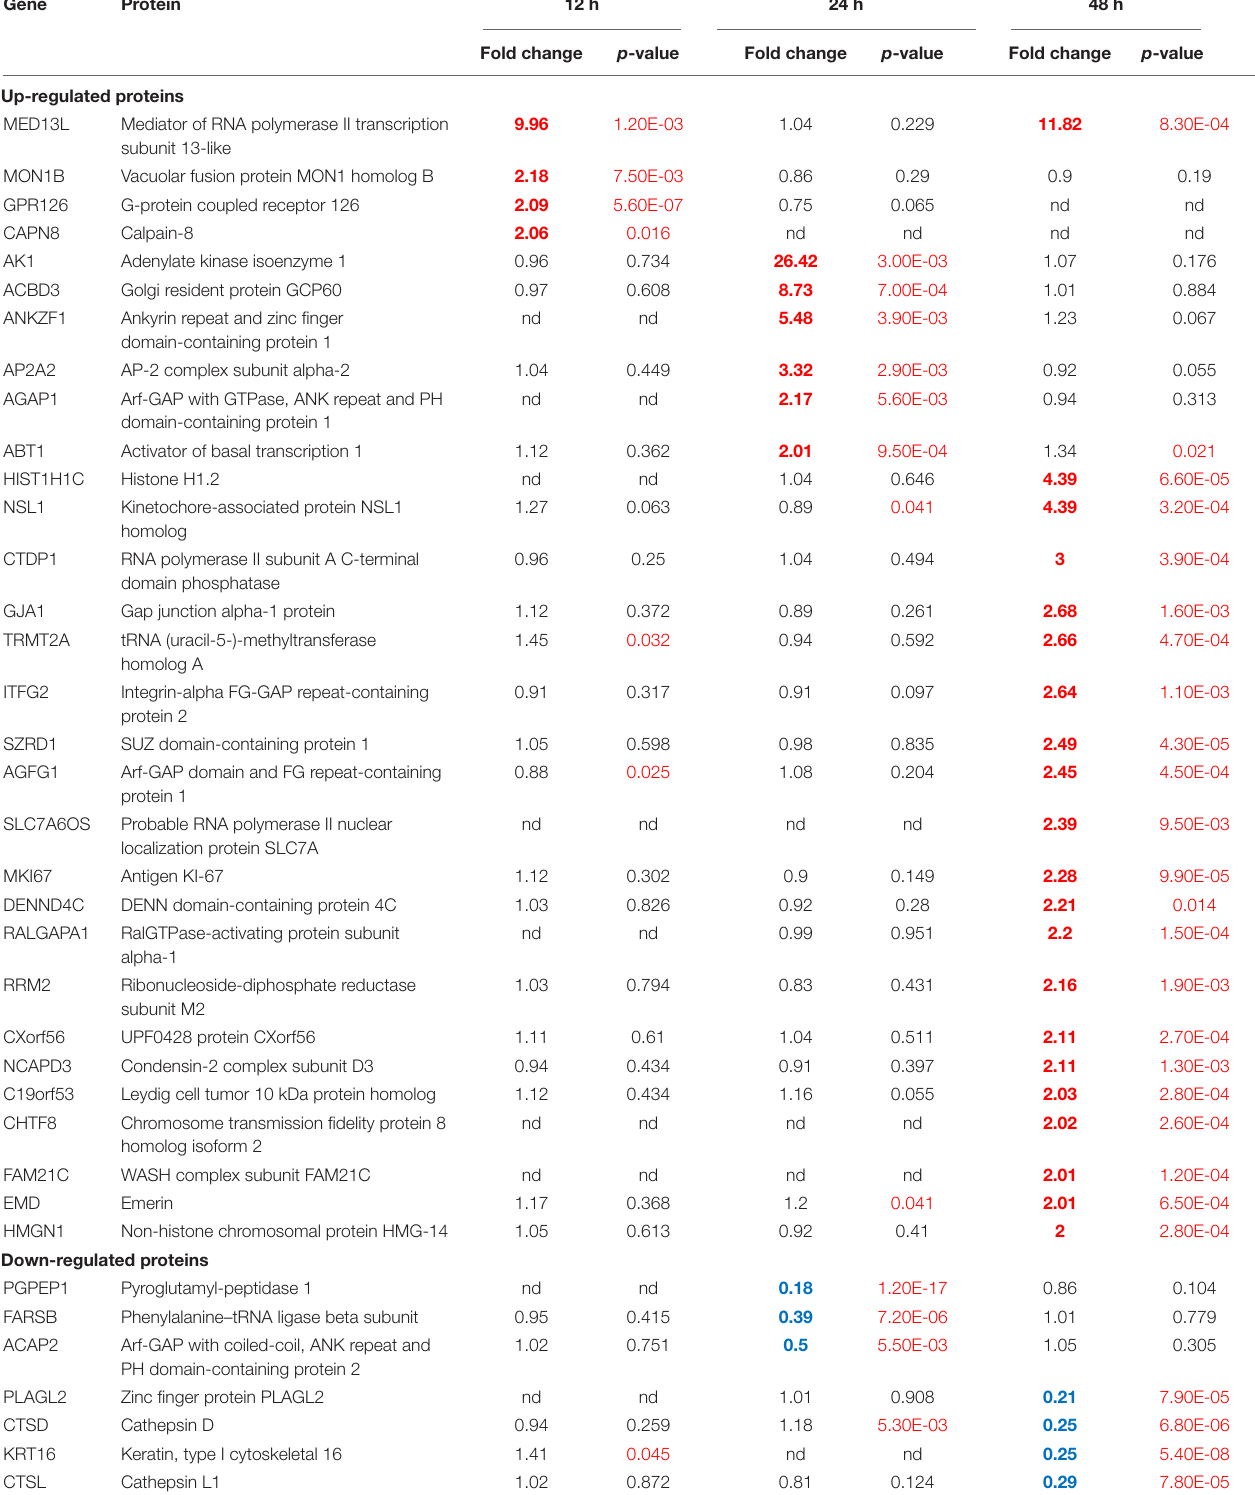
TABLE 2 | Vero cell proteins dysregulated ≥ 2.0-fold by ZIKV infection. Gene Protein 12 h 24 h 48 h Fold change p -value Fold change p -value Fold